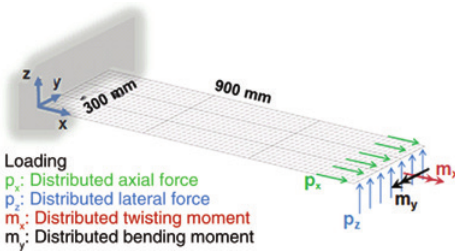
Figure 10: Description of the clamped-free ended flat-plate